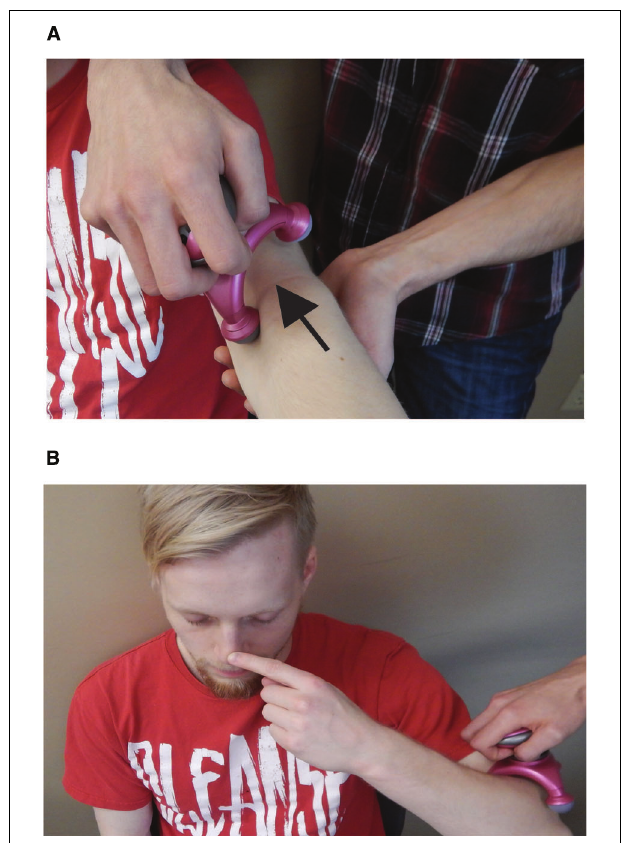
signals the extension of the arm (an increase in elbow joint